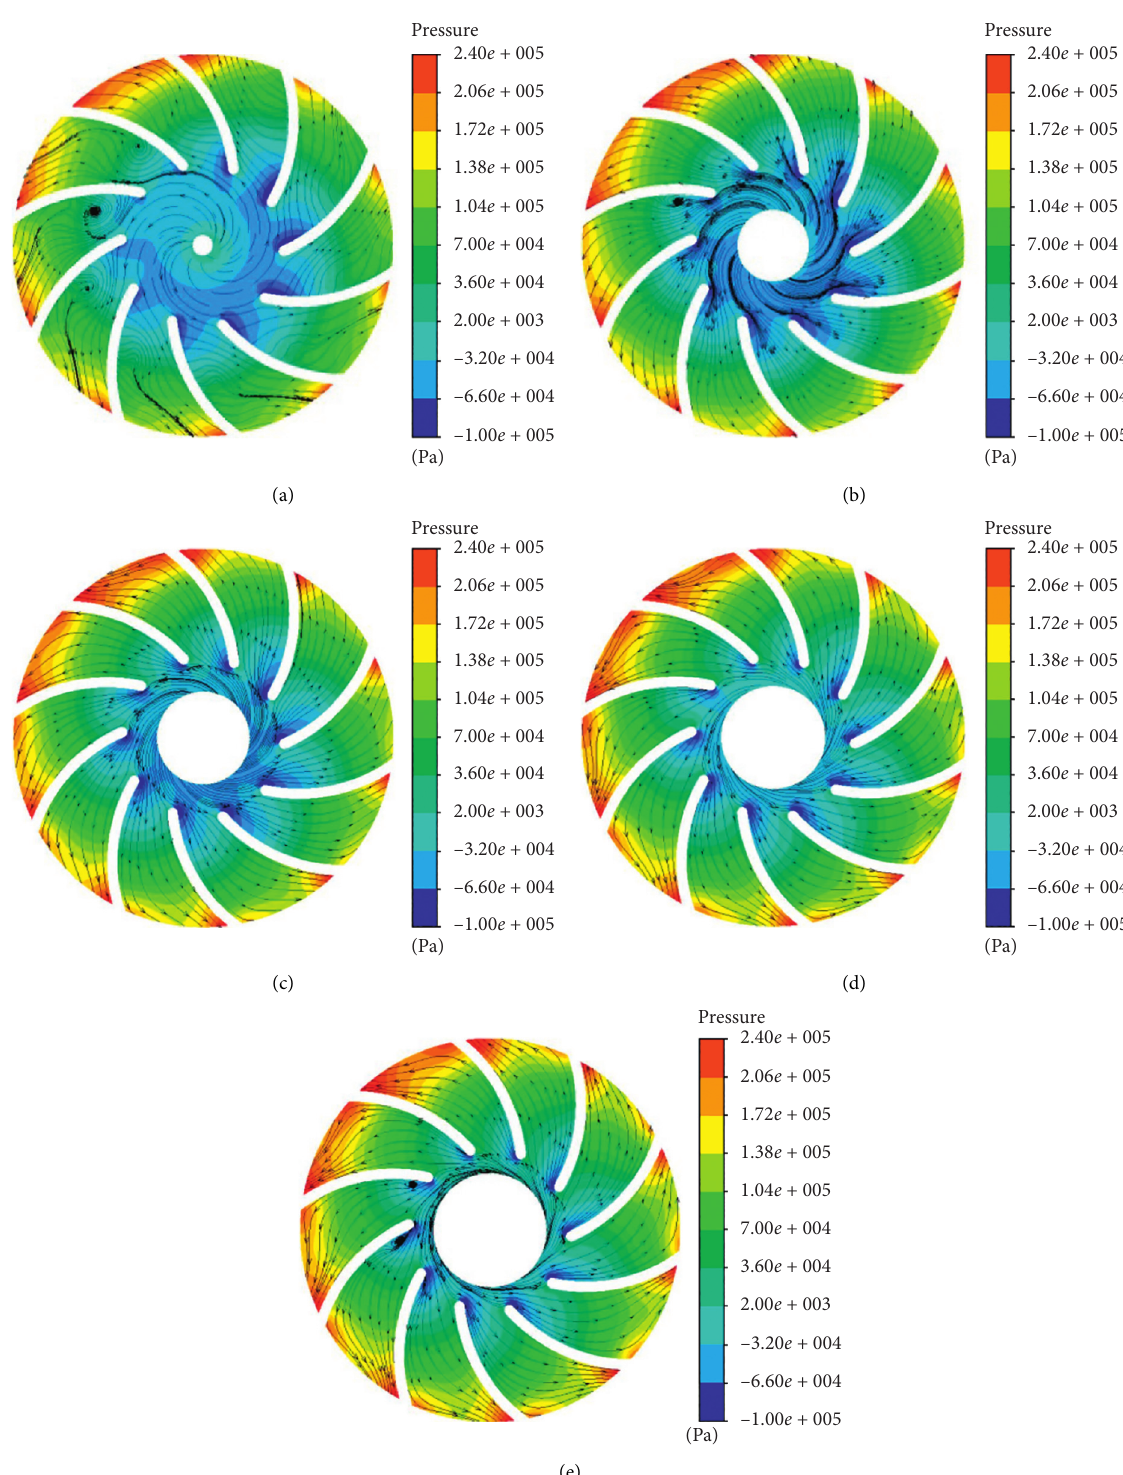
Figure 11: Pressure (Pa) and relative velocity vectors in the average cross-sectional plane of the impeller: (a) S1; (b) S2; (c) S3; (d) S4; (e)